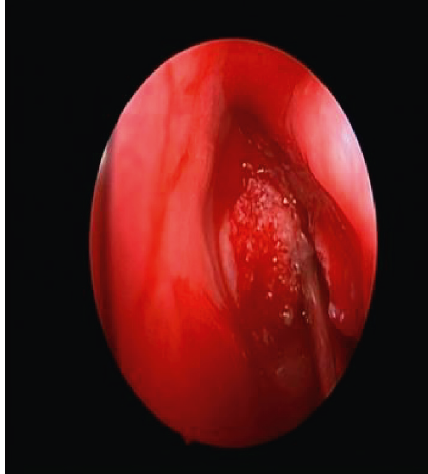
Figure 5: The intraoperative endoscopic image shows a bony mass filling the choana.